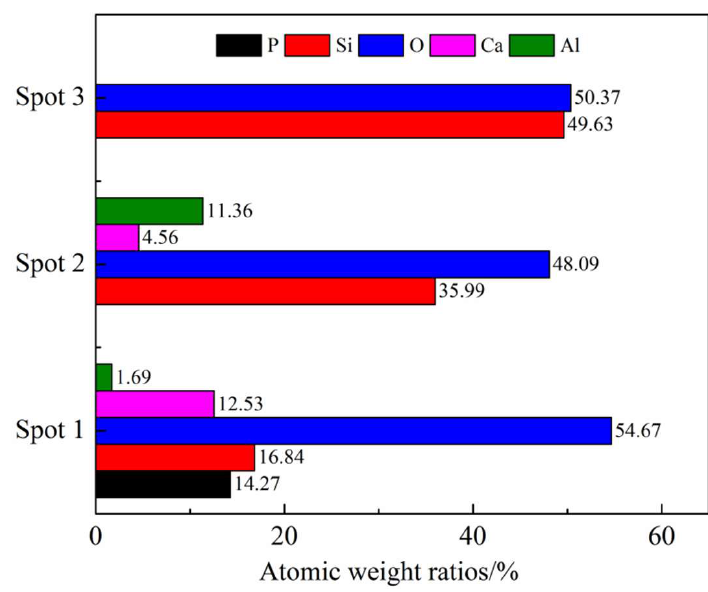
Figure 15. EDS analysis results in the slag phase of spots 1 to 3.